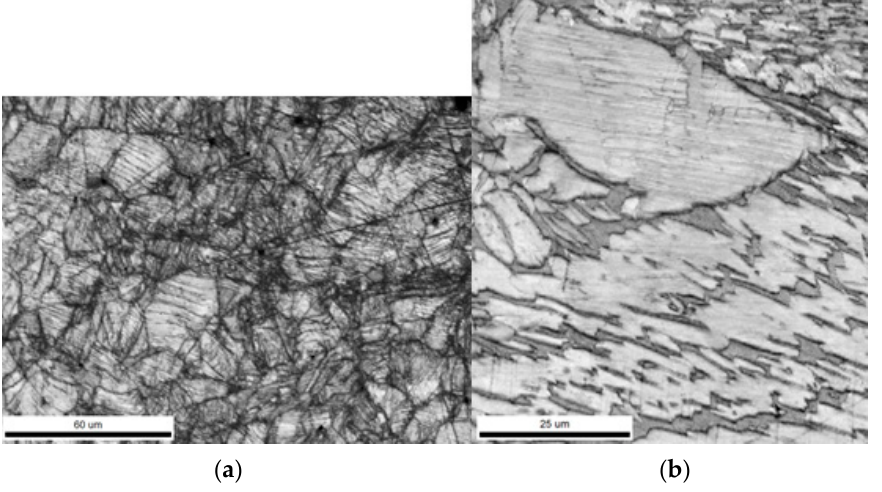
Figure 10. Strain markings close to the fracture surface of ( a ) CuZn38As as-drawn and ( b ) CuZn38As heat treated alloy sample. EBSD image quality map. heat treated alloy sample. EBSD image quality map. Unit: µ